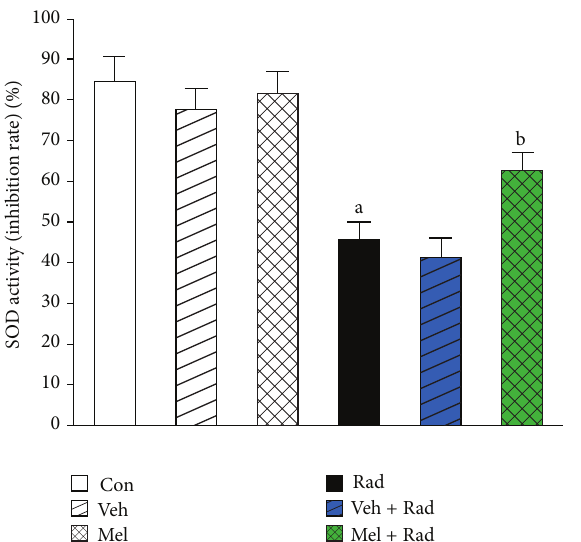
Figure 7: The effect of melatonin on CAT activity in rats subjected to whole body gamma irradiation. Data represent mean ± standard error on the mean (SEM) for 5 animals per group. Con: Control group, Veh: Vehicle only group, Mel: Melatonin only group, Rad: Radiation only group, Veh + Rad: Treated with vehicle and exposed to10 Gyradiation,andMel+Rad:Treatedwith100 mg/kgmelatonin before exposure to 10 Gy radiation. a 𝑃 < 0.001 when compared to Control group. b 𝑃 < 0.001 when compared to the Radiation only group.